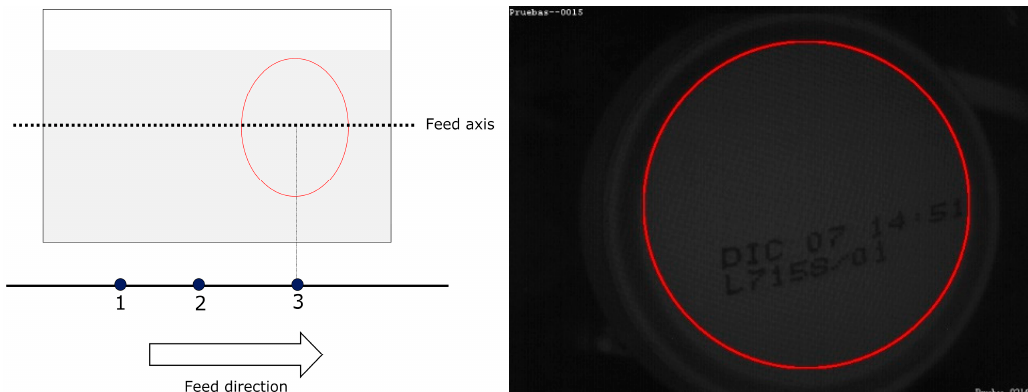
Figure 7. The Can state persists. There are no new events.